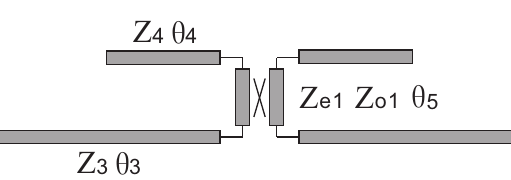
Figure 3. Equivalent circuit of anti-parallel coupling network in lower path